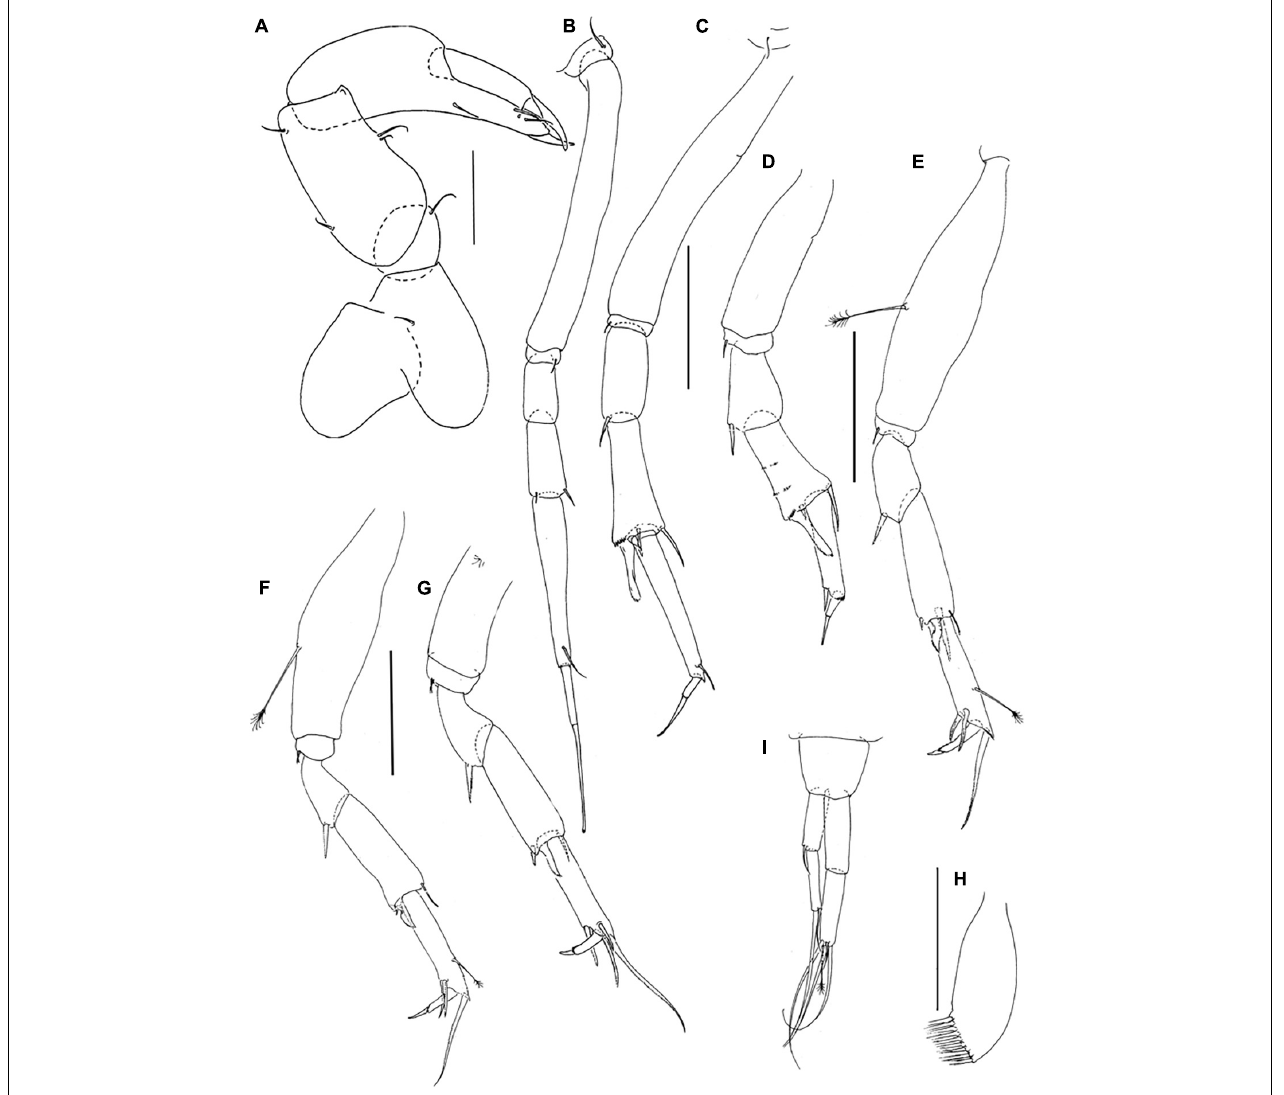
FIGURE 7 | Pseudotanais barossai sp. nov.; neuter (J61545), (A) , cheliped; (B) , pereopod-1; (C) , pereopod-2, (D) , pereopod-3; (E) , pereopod-4; (F) , pereopod-5; (G) , pereopod-6; (H) , pleopod; (I) , uropod. Scale lines = 0.1 mm.